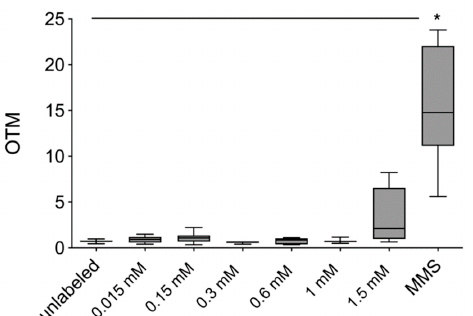
Figure 3. Comet Assay: No significant increase in olive tail moment (OTM) values and thus in DNA fragmentation was observed after labeling of hASCs. A significant increase in OTM values after exposure to 200 µM MMS, which served as a positive control, was determined compared to unlabeled hASCs. Significance is indicated by asterisks (* p < 0.0001).